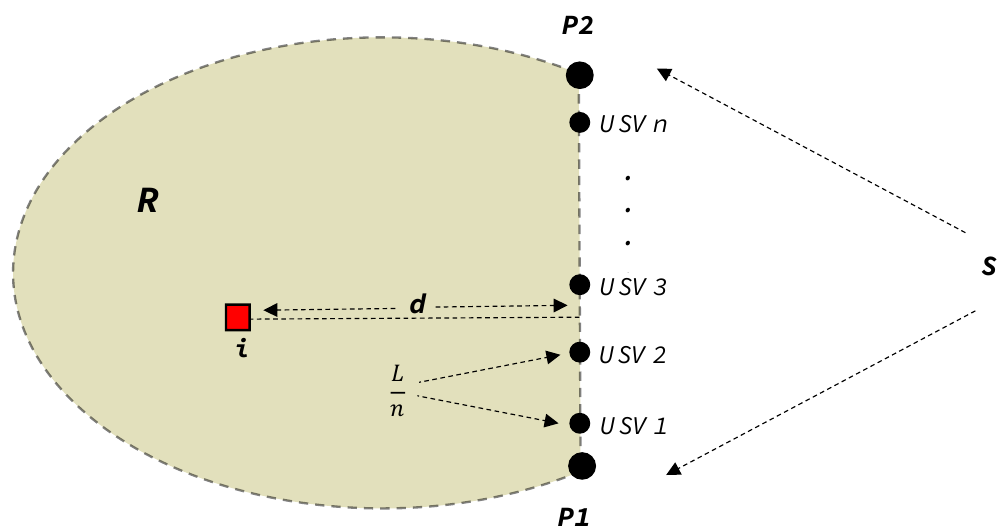
Figure 2. Deployment of autonomous unmanned surface vehicles (USVs) on a straight line segment S